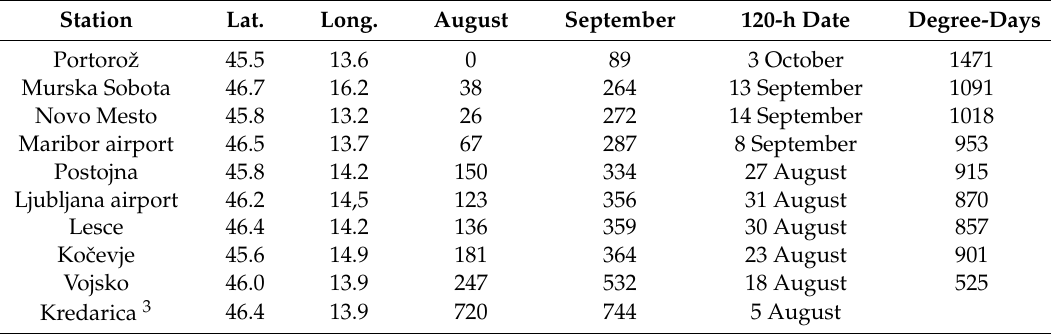
Table 1. Hours below 15 ◦ C in August and September for 10 sites in Slovenia, from lowest to highest in September. The airports in Ljubljana and Maribor are well outside the city limits, so they were used. Kredarica is in the mountains and is not representative for wheat storage but was used to make the climate map 1,2 .